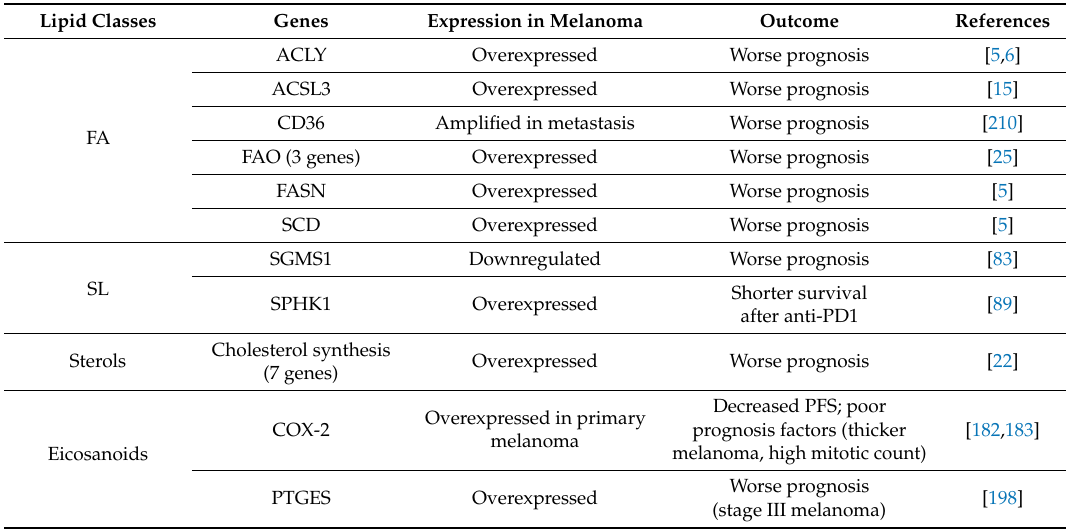
Table 1. Relationship between expression of lipid metabolism associated genes and prediction of melanoma patient